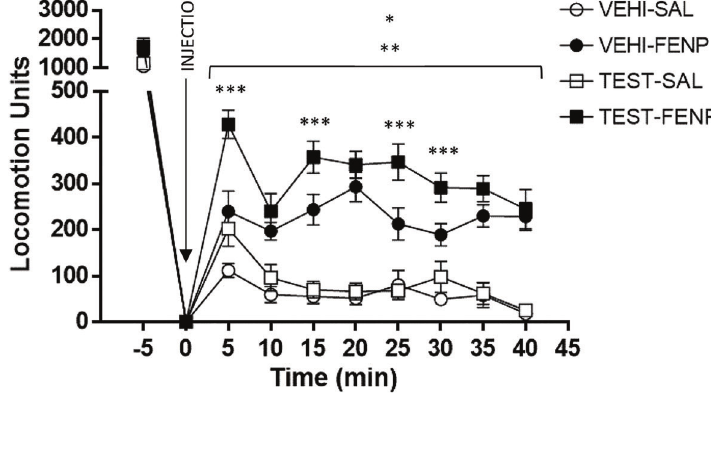
Figure 2. Locomotor activity following fenproporex (3 mg/kg, ip ) challenge in adult rats (PND 81, n= 24) pretreated with repeated testosterone injec- tions (10 mg/kg, sc ) from PND 68 to PND 78. Locomotor activity was measured during 40 min. Data are reported as means ± SE. -5 min: habitua- tion. *P o 0.05: vehicle-fenproporex (VEHI-FENP) signi fi cantly different from vehicle-saline (VEHI-SAL). **P o 0.05: testosterone-fenproporex (TEST-FENP) signi fi cantly different from testosterone-saline (TEST- SAL) (three - way ANOVA followed by Newman- Keuls ’ test).